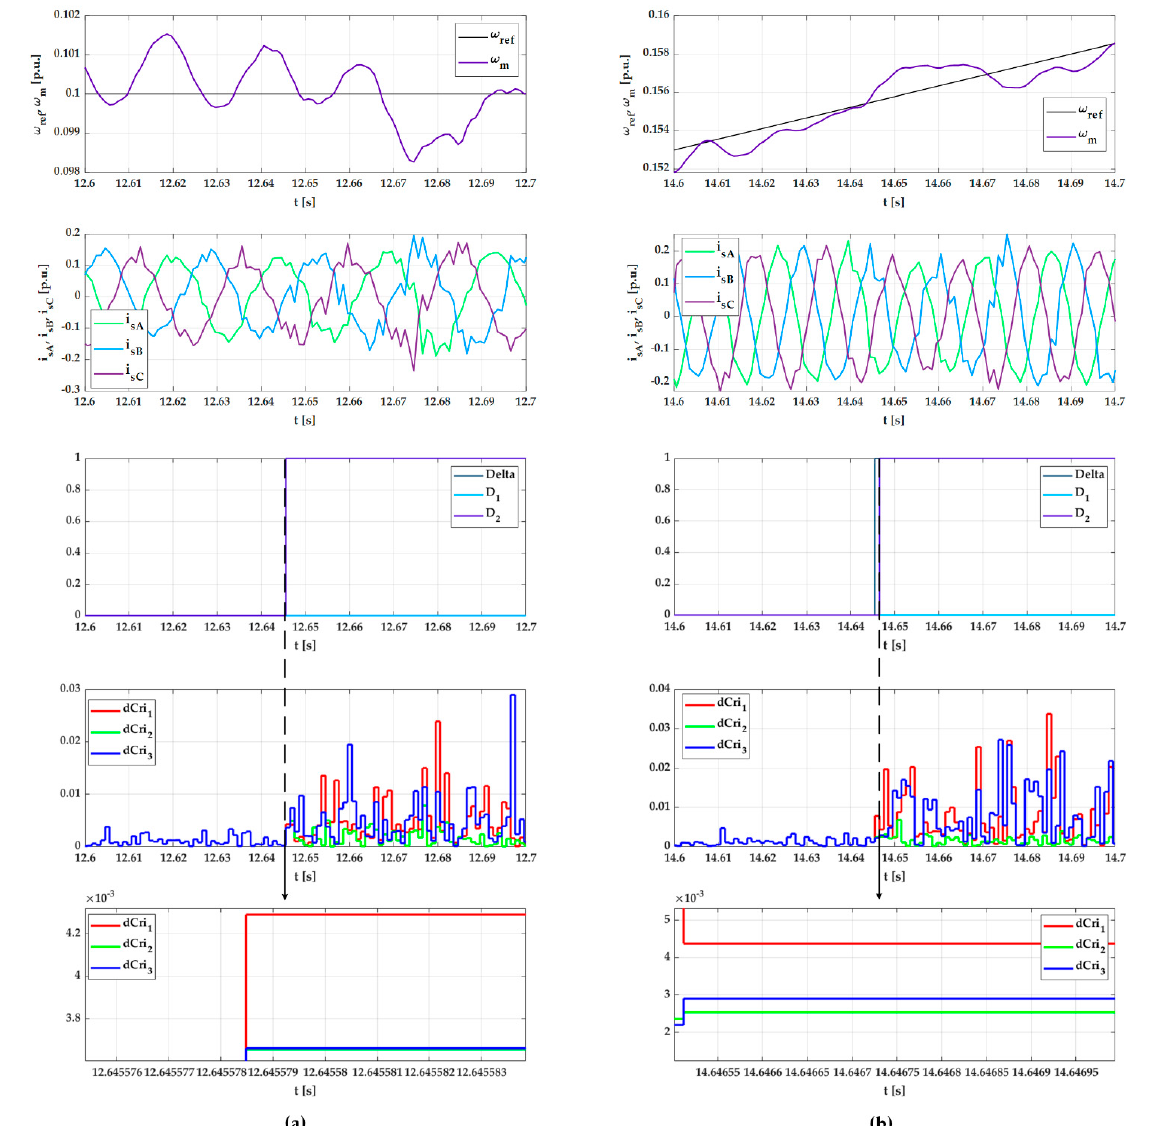
Figure 10. Transients of speed, stator currents, detector responses, and marker errors during signal noise (70 dB) in phase B for different speed values in stable ( a ) and dynamic ( b ) states.